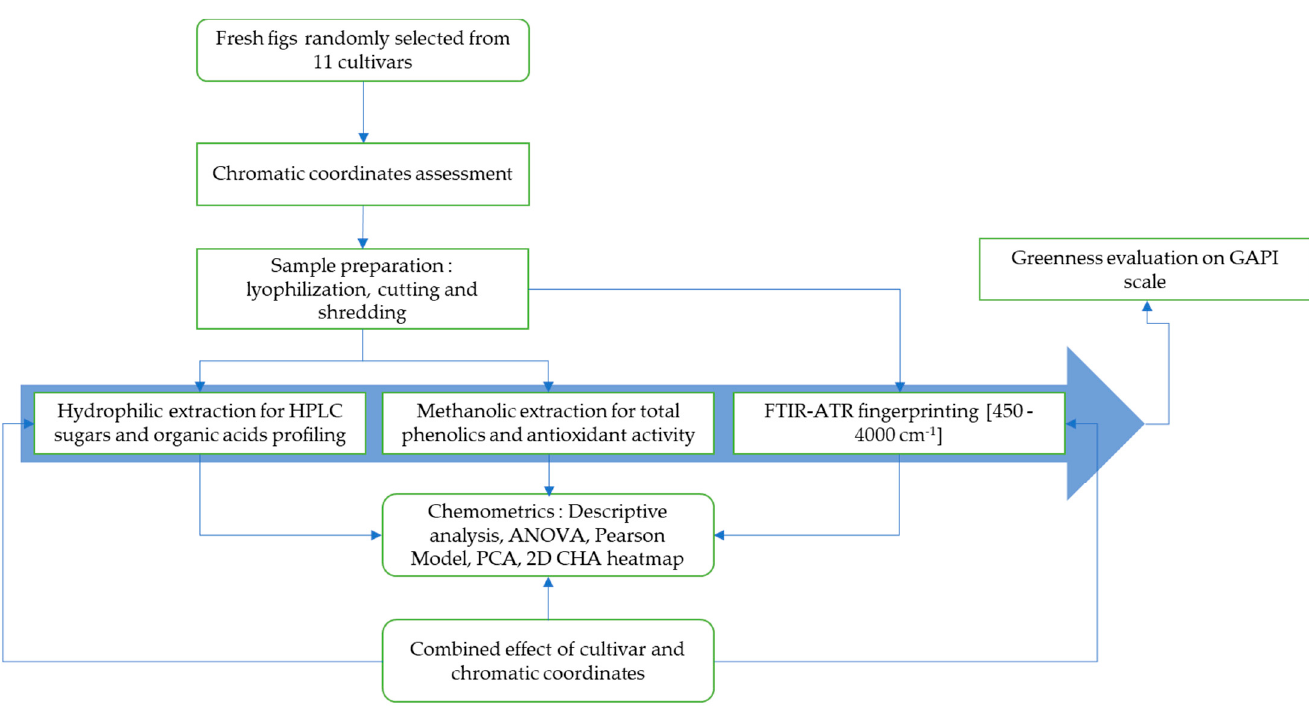
Figure 1. Flow chart of the steps involved in this study, showing how data were acquired and monitored to examine the effect of cultivar and peel chromaticity on primary and secondary metabolites. ANOVA: analysis of variance; PCA: principle component analysis; 2D CHA heatmap: two-dimensional clustered heatmap.